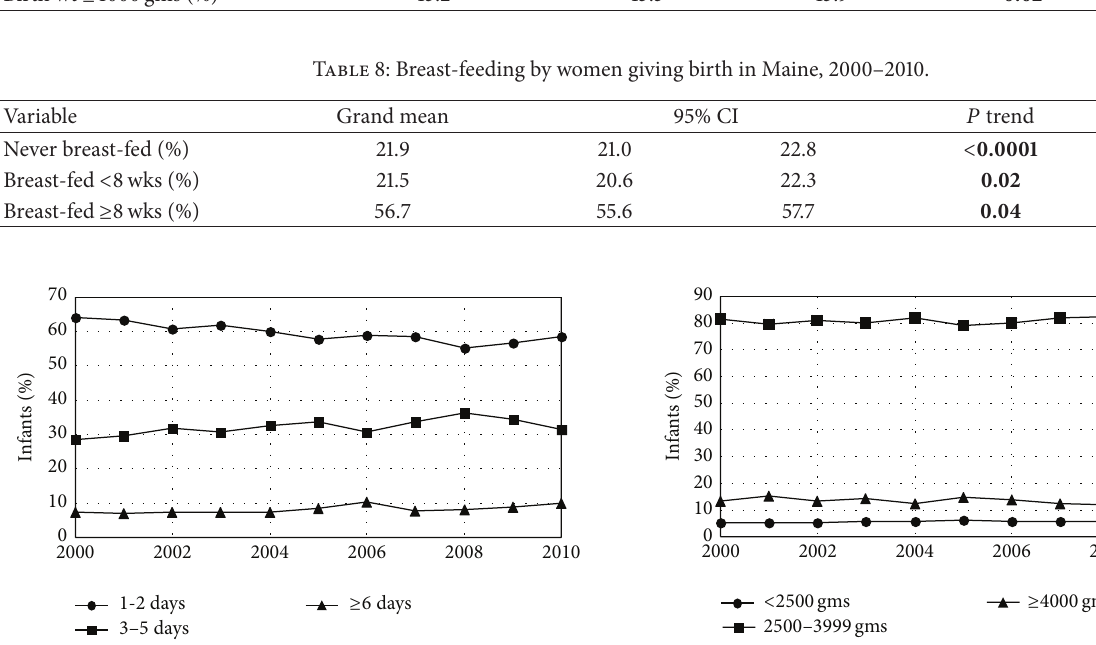
Figure 6: Hospital length of stay for infants born in Maine hospitals by year. The fraction of infants who were hospitalized for 1-2 days after birth declined while the fraction hospitalized in both of the two longer stay categories increased.